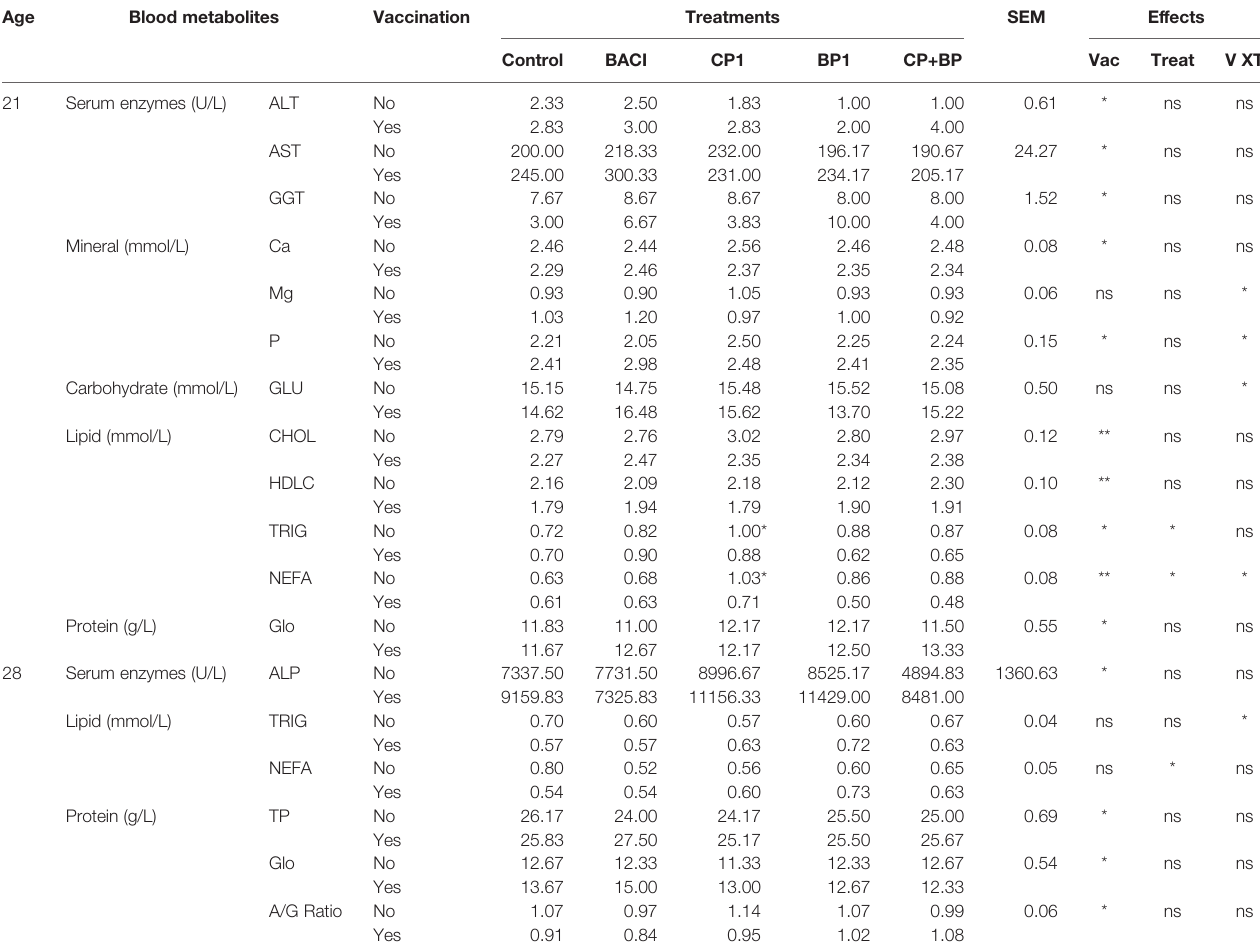
TABLE 4 | Blood serum metabolites level of broiler chickens showing signi fi cant dietary treatment and/or vaccination effects. Age Blood metabolites Vaccination Treatments